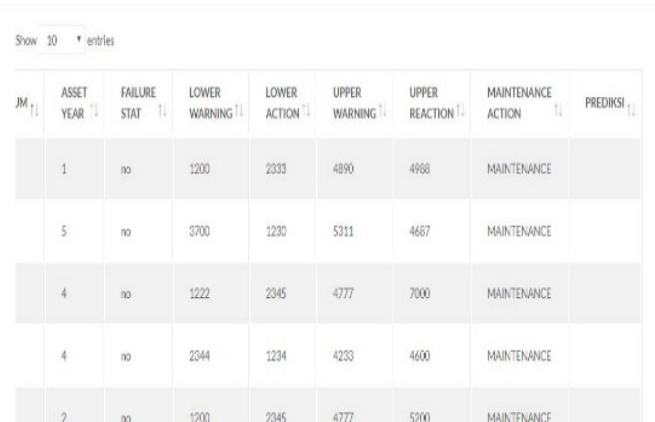
Fig. 13. Data Set Display Page